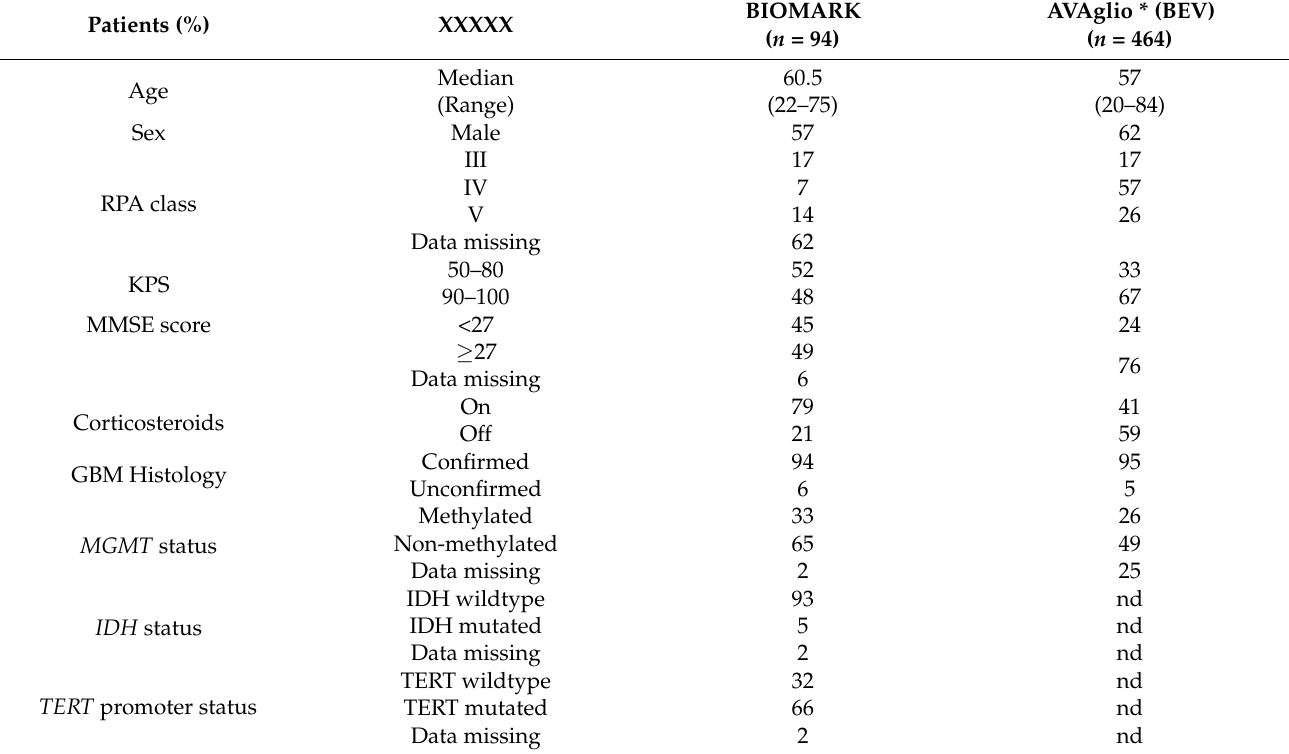
Table 1. Patients’